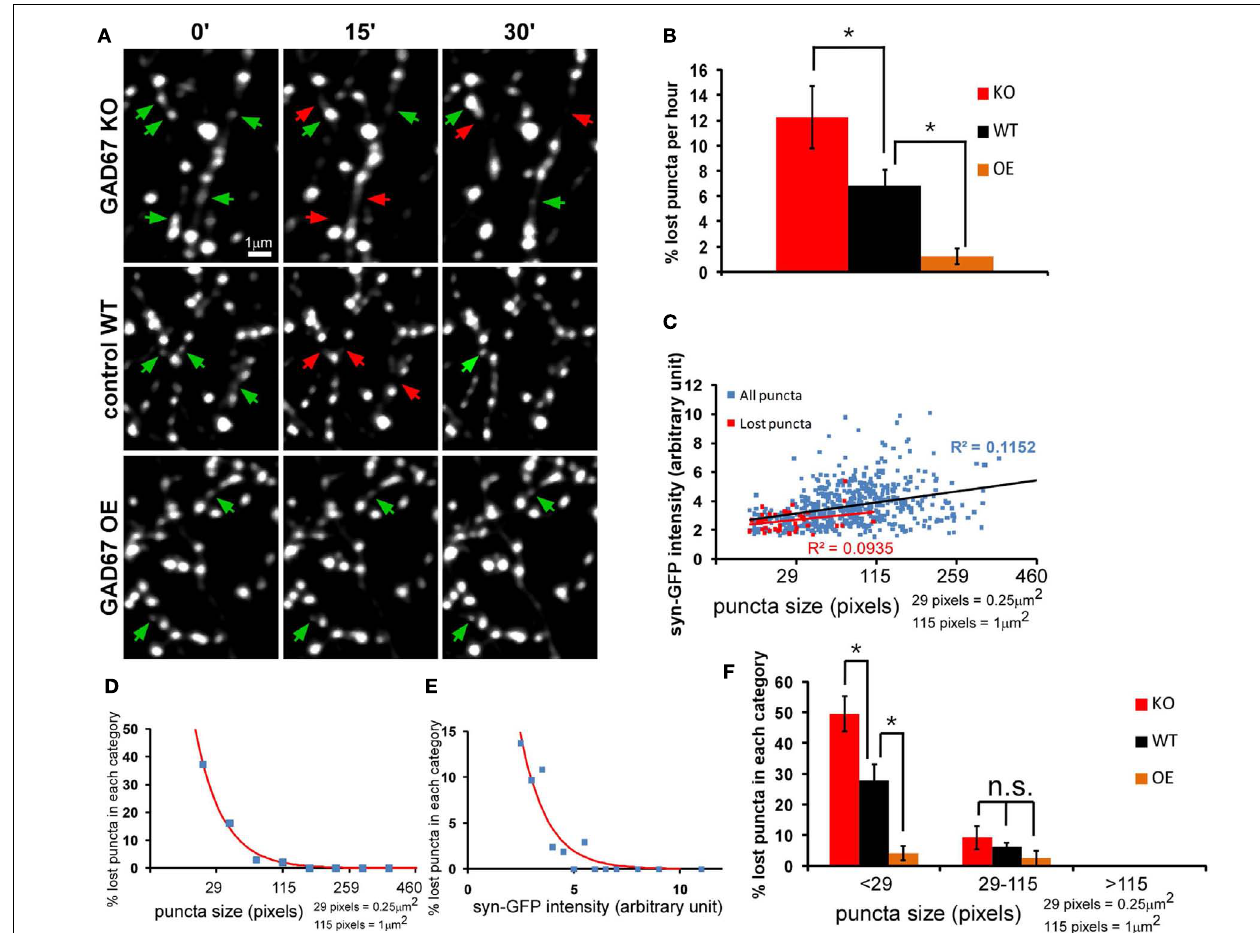
regression was applied for both groups and R 2 were displayed. (D) The size of all syn-GFP puncta and lost puncta ofWT cells was binned.The number of lost puncta in each category was divided by the number of total syn-GFP puncta in that category to derive the percentage of lost puncta in that category.The red line is the fitted curve with function y = a × exp( − x / b ). (E) The intensity of all syn-GFP puncta and lost puncta was binned with arbitrary unit.The number of lost puncta in each category was divided by the number of total puncta in that category to calculate the percentage of lost puncta.The red line is the fitted curve with function y = a × exp( − x / b ). (F) Both the whole syn-GFP puncta population and the lost puncta population were classified according to their size.The percentage of lost puncta in each category was determined as the number of lost puncta in that category divided by the number of total puncta in that category. Significant change was only found in the < 29-pixels group (one-way ANOVA P = 0.0002, post hoc Dunn’s test, * p <